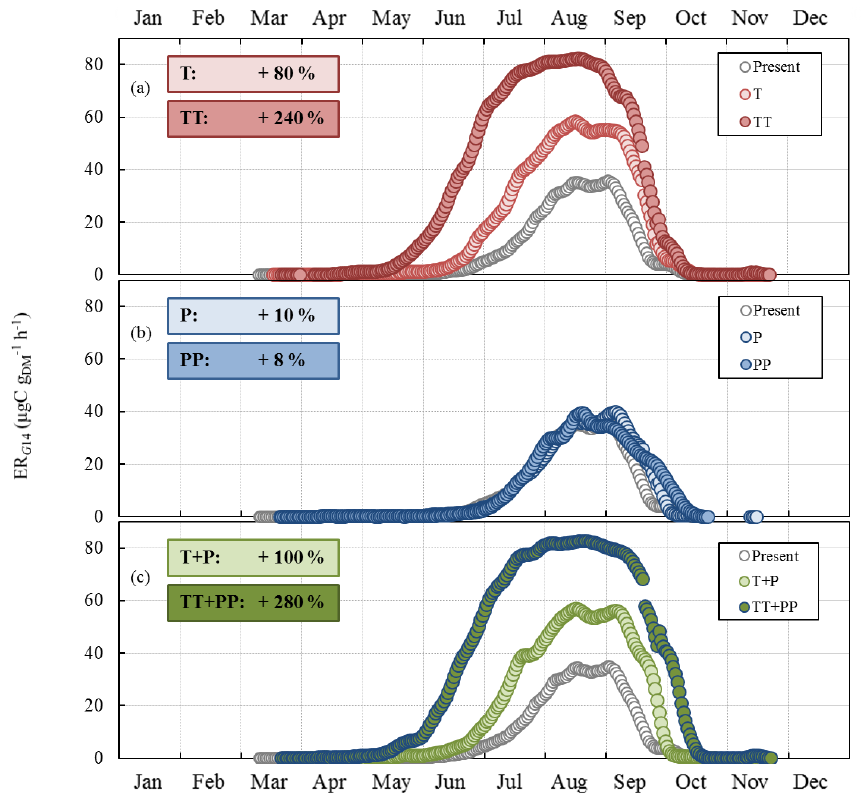
Figure 8. Sensitivity of the seasonal variation of isoprene emission rates calculated using G 14 (ER G 14 , in µgCg − 1 and ST changes as in RCP2.6 ( T case) and RCP8.5 ( TT case) respectively; (b) SW and P changes as in RCP2.6 ( P case) and RCP8.5 ( PP case) respectively; and (c) combined T , ST, P , and SW changes as in RCP2.6 ( T + P case) and RCP8.5 ( TT + PP case) respectively. Present and future cases were calculated for 2000–2010 and 2090–2100 respectively. Overall annual relative changes to present are